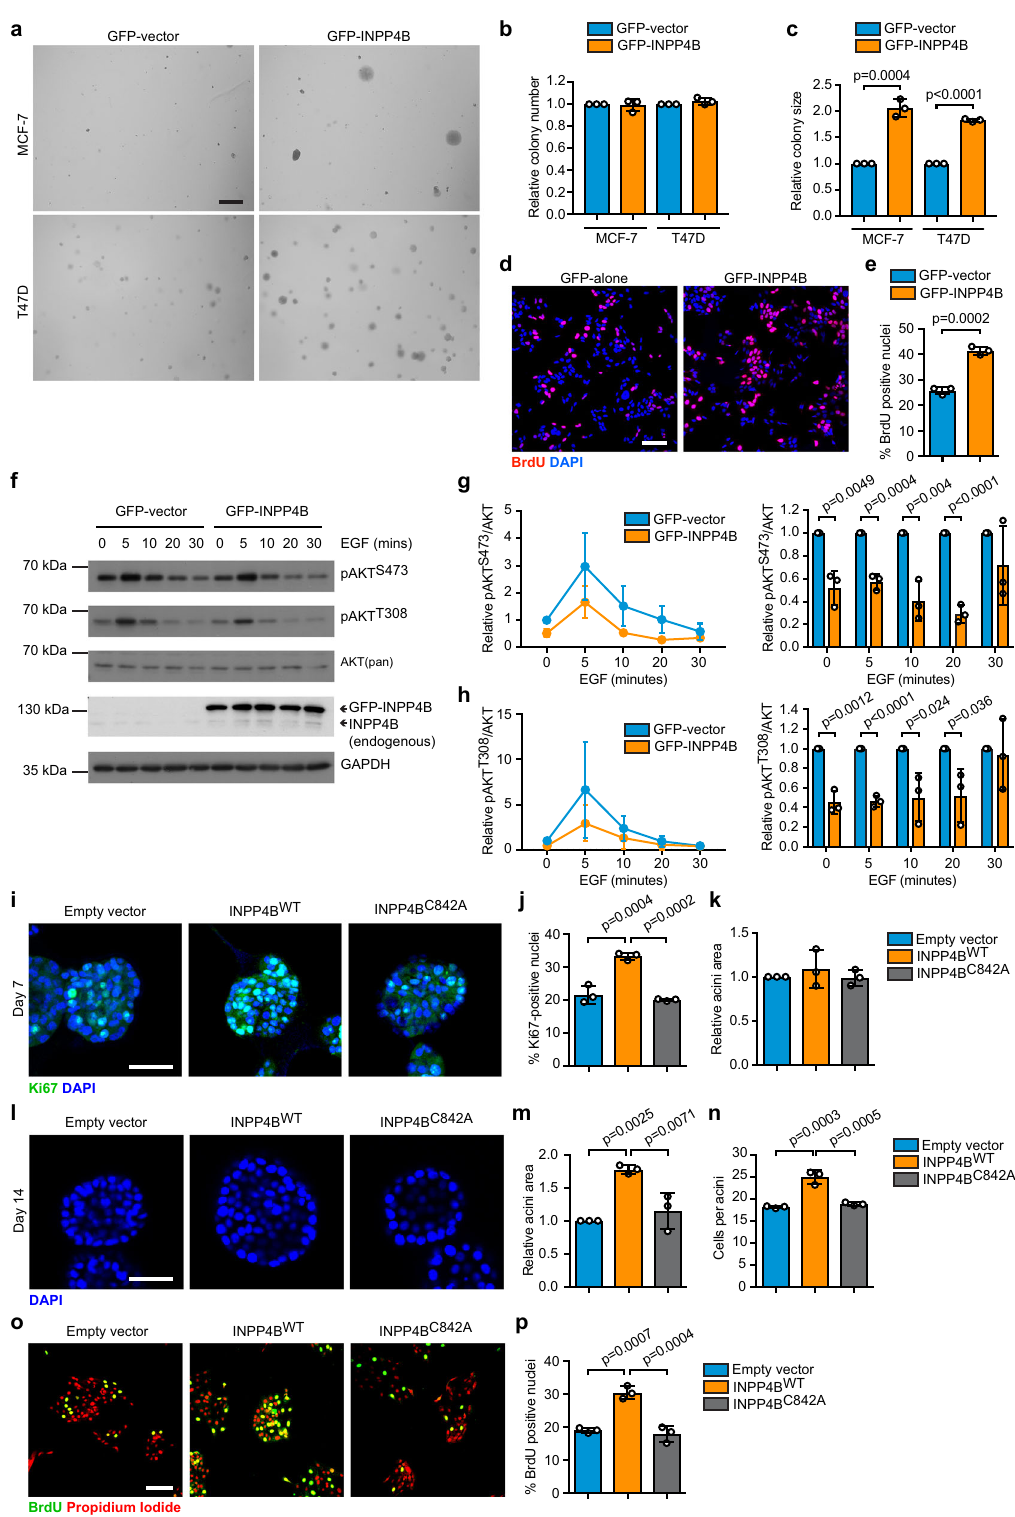
proliferation despite reducing AKT activation. In addition, GFP- used here to activate AKT and SGK3 signaling 23 . We also cannot INPP4B expression had no effect on PTEN protein levels (Sup- exclude the possibility that the level of INPP4B overexpression plementary Fig. 2g, h) or EGF-mediated SGK3 T320 phosphor- generated by our studies was insuf fi cient to hyperactivate SGK3. Next, we assessed whether INPP4B regulates the morphogen- ylation (Supplementary Fig. 2i, j), suggesting the INPP4B esis of three-dimensional epithelial spheroids using MCF-10A phenotype we observed is not mediated by alterations in PTEN mammary cells that express wild-type PIK3CA , which form and/or SGK3 signaling. These results differ from that described polarized, growth-limited acini in 3D Matrigel culture 26 . After by Gasser et al. who used IGF-1, rather than EGF stimulation as NATURE COMMUNICATIONS| (2021) 12:3140